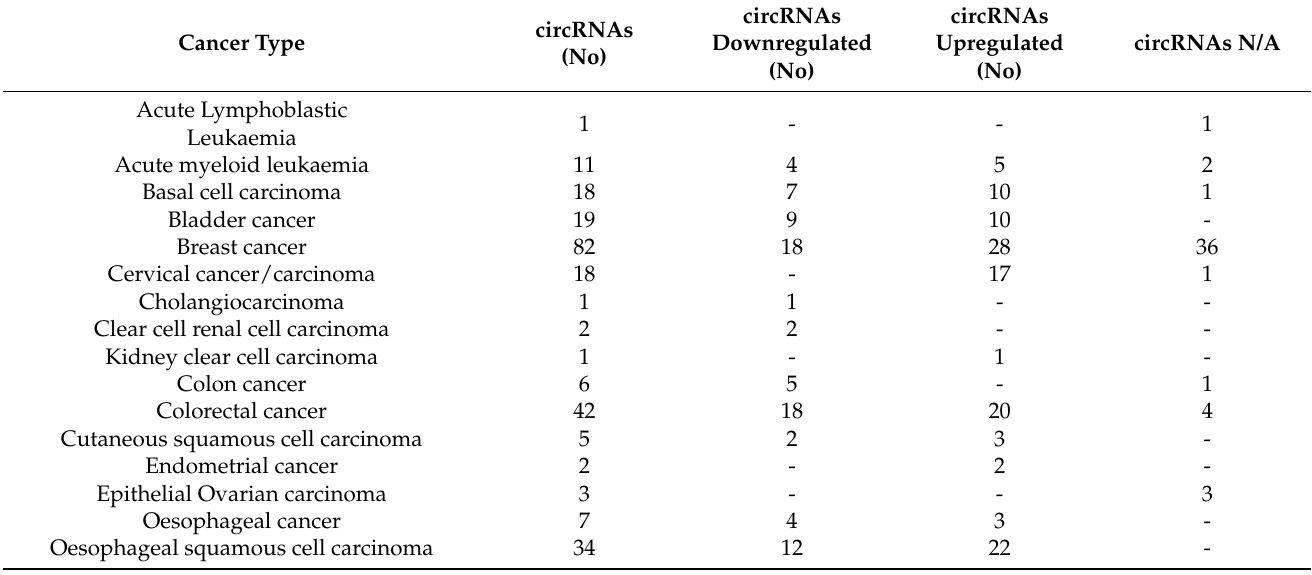
Table 1. CircRNA in cancer